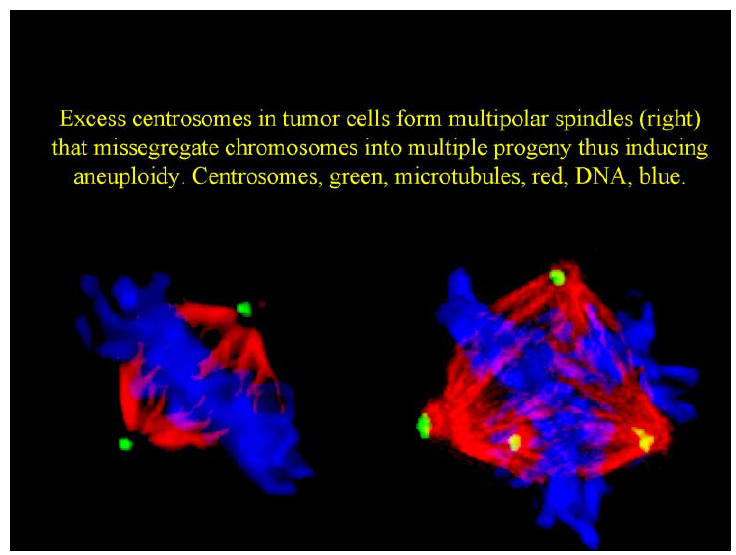
Fig. 1. Centrosomes and mitotic spindle organization in normal and tumor cells. Immunofluorescent image of centrosomes in a nontumor cell that organize a normal bipolar spindle in mitotis (left). A cell from a breast tumor showing excess centrosomes that organize a multipolar spindle (right) that induces chromosome missegregation aneuploidy. Images: Keith Mikule and Steve